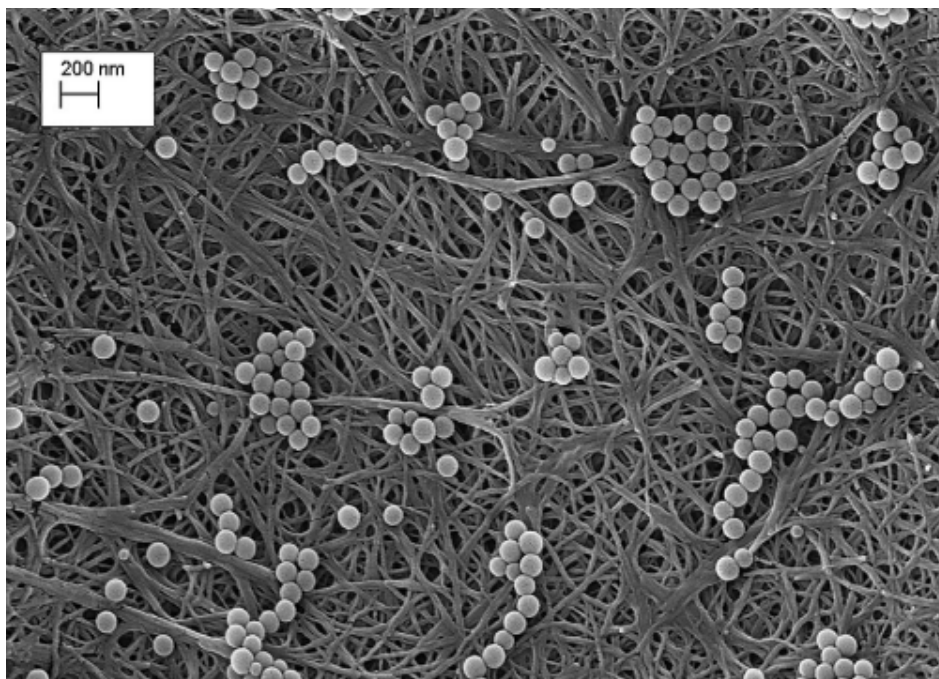
Figure 6. SEM images of 100 nm latex beads retained on the nanocellulose membrane filter. Repro- duced with permission from [97].